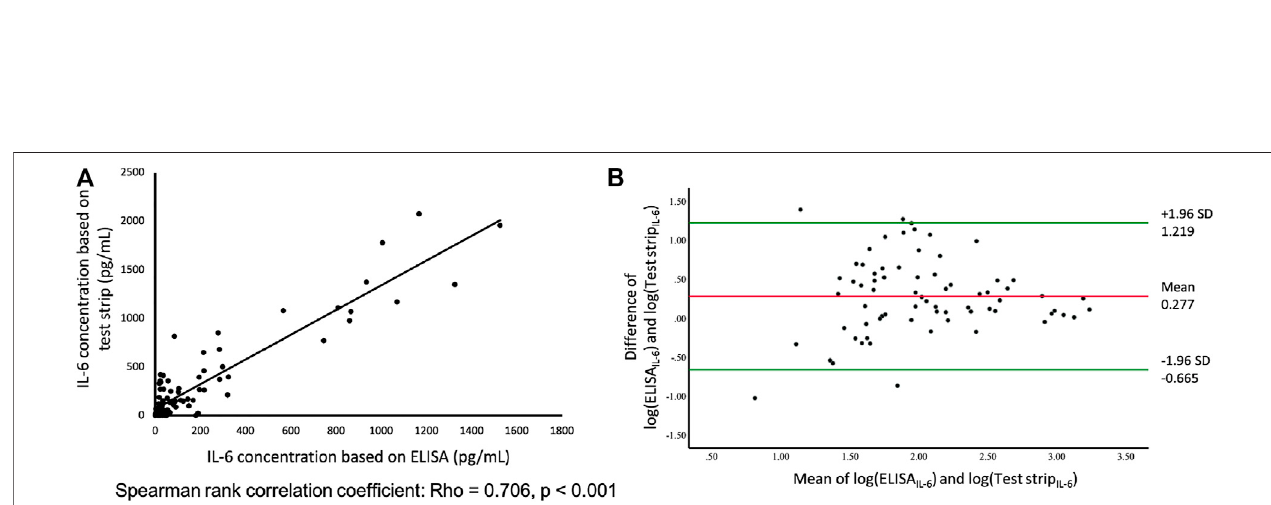
FIGURE2|(A) Comparisonofpaper-basedteststripandELISAforIL-6assaysusingserum frompatients,includingin fl uenza,enterovirus, Mycoplasma ,dengue, n (cid:1) 83. Y -axis; IL-6 concentration measured by test strip. X -axis; IL-6 concentration measured by ELISA. (B) Bland and Altman plot of log-transformed data. The differences between theIL-6basedon teststrip and ELISA(log transformation) inrelation tothe meanofthetwomeasurements(logtransformation), n (cid:1) 83.Greenlines indicate the limits of agreement ( ± 1.96 SD).